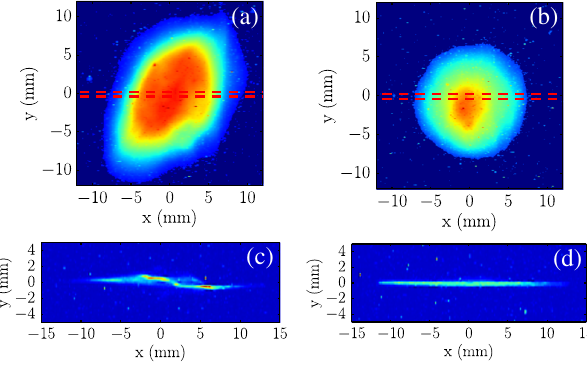
FIG. 6. Beam transverse distribution at YAG5 [(a), (b)] and associated distribution of the beamlet transmitted through a horizontal slit located at YAG5 location and measured at YAG6 [(c), (d)]. The set of images [(a), (b)] [respectively (c), (d)] corresponds to the case when the MLA was retracted [respectively inserted] from the laser-beam path. The horizontal dashed line in (a) and (b) represents the aperture of the